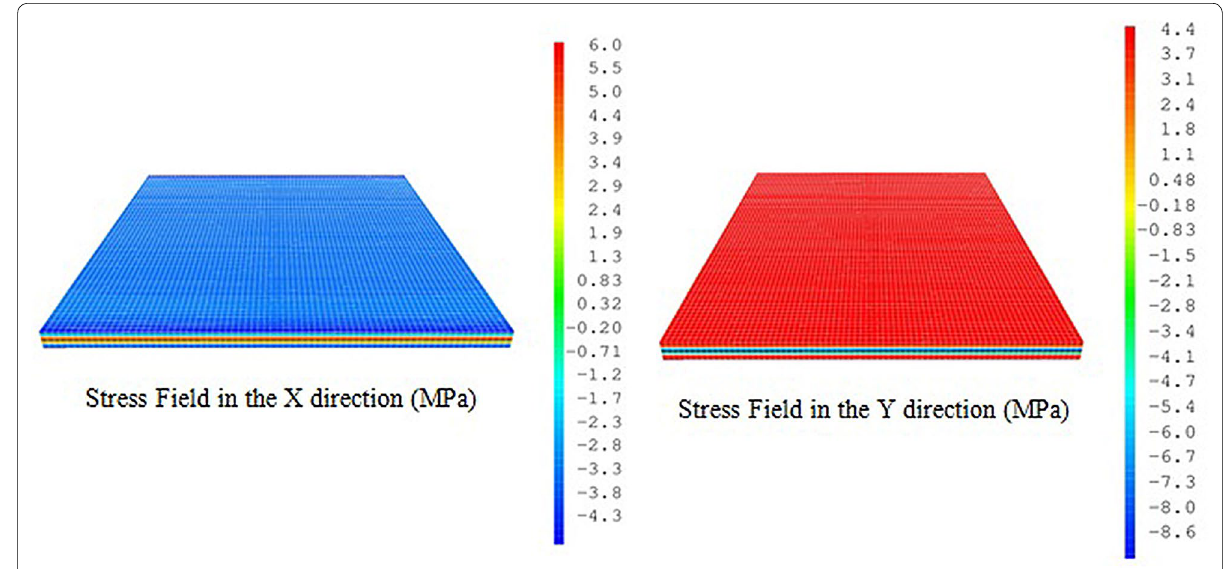
Fig. 15 Stress fields obtained numerically after 50